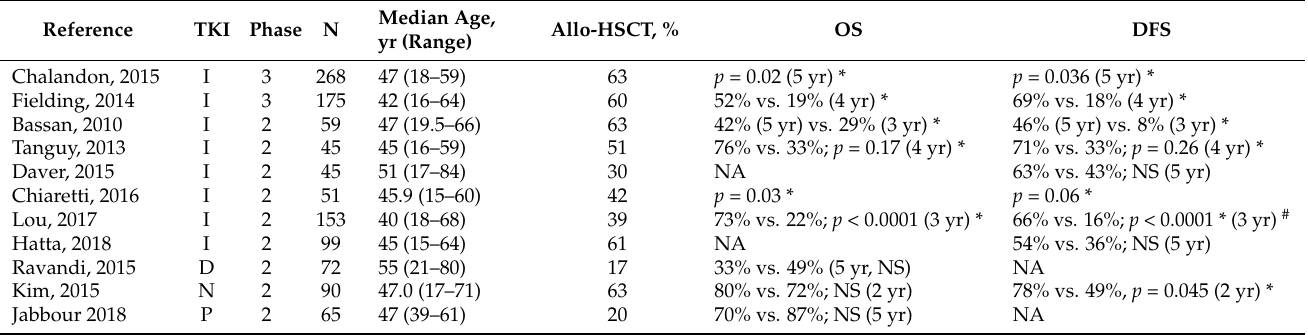
Table 3. Outcome of adult Ph+ ALL patients according post remission strategy: allo-HSCT versus no